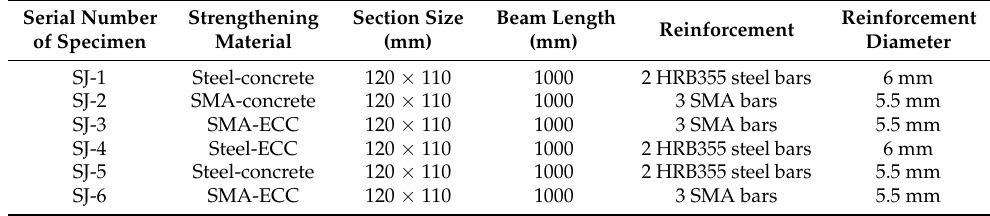
Table 1. The design parameters of specimens.